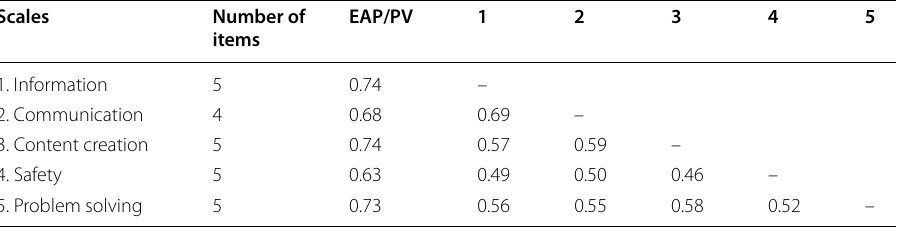
EAP/PV Expected-a-posteriori/plausible value reliability = All correlations are significant ( p < 0.01)